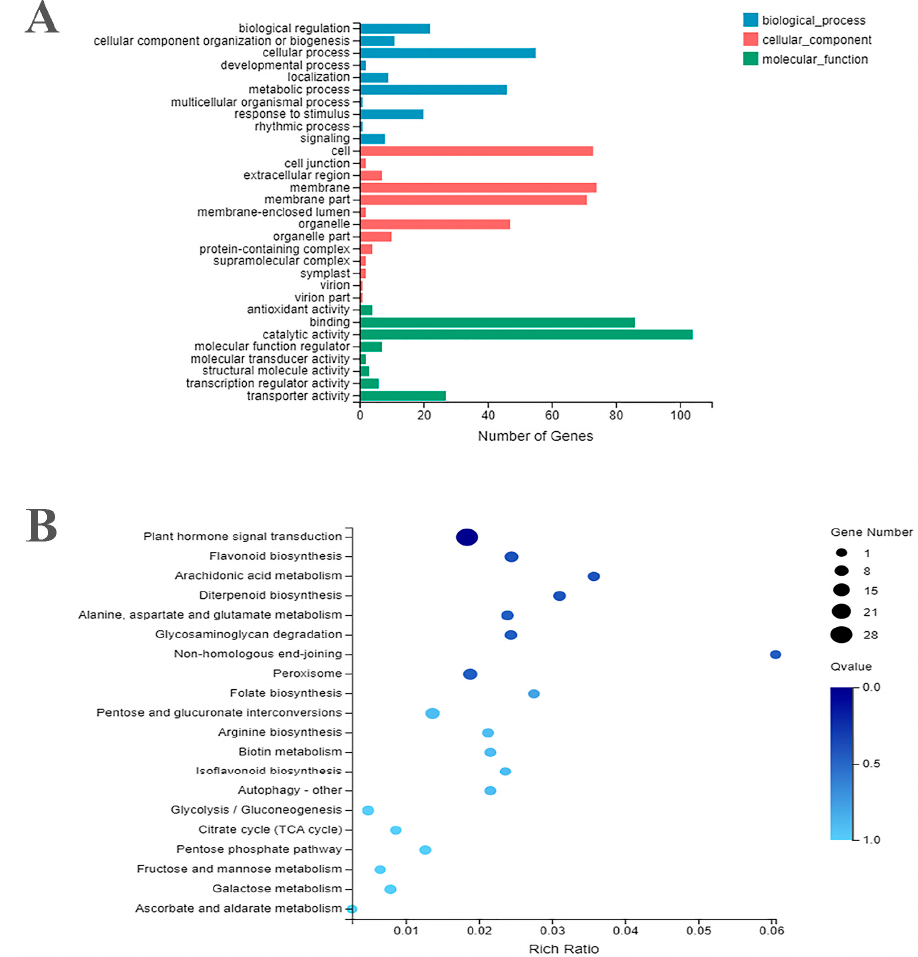
Figure 2. Functional annotations and KEGG pathway enrichment analysis of differentially expressed genes identified from safflower. ( A ) GO terms classification into three main categories: MF, CC, and BP. The distribution of genes in each term is shown alongside the x -axis ( B ) The scatterplot of the top 20 enriched KEGG pathways in safflower. The x -axis shows the rich ratio of DEGs to the total number genes in each pathway.